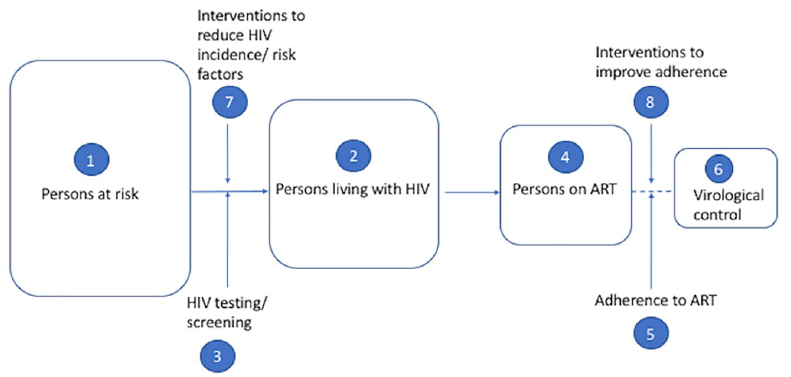
Fig 1. Conceptual framework. ART: antiretroviral